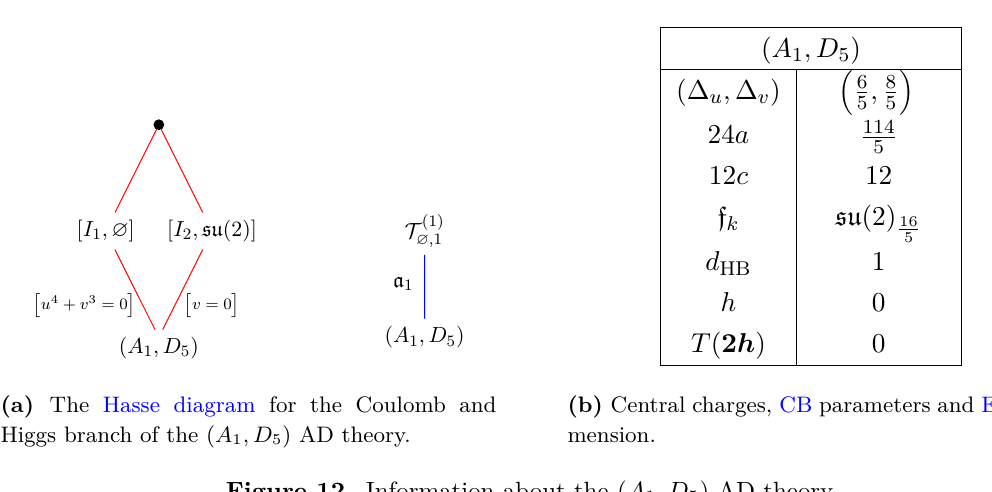
Figure 12. Information about the ( A 1 , D 5 ) AD